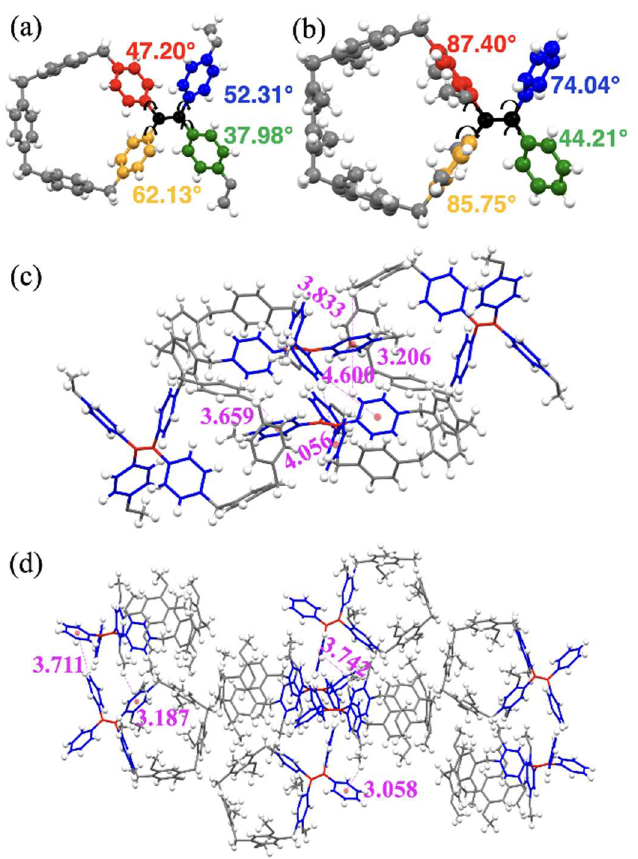
Figure 1. Top view of crystal structures PCP[5]-TPE and DMP[5]-TPE ( a , b ) and molecular packing of PCP[5]-TPE and DMP[5]-TPE ( c , d ), Hexane solvent molecules are omitted for clarity.